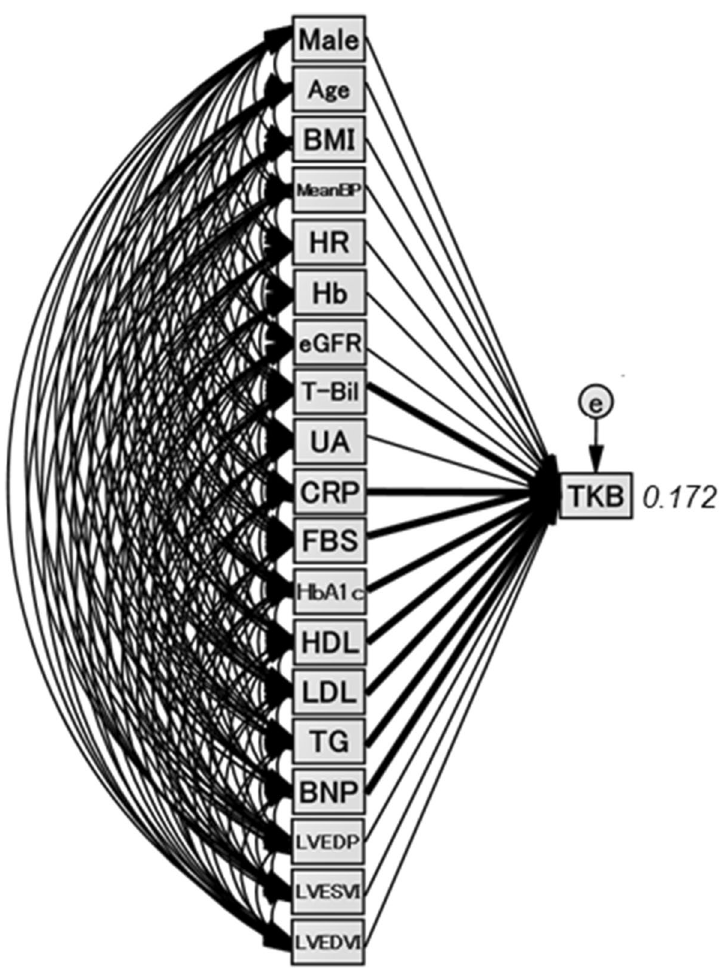
Figure 1. Path model (A). The path model theoretically proposed to clarify the contribution of each of the factors which are show in Table 2 to TKB. Each path has a coefficient representing the standardized coefficient of a regressing independent variable on a dependent variable of the relevant path. These variables represent the standardized regression coefficients (direct effect) (shown in Table 3) and squared multiple correlations (in narrow italics). BMI body mass index, Mean BP mean blood pressure, HR heart rate, Hb hemoglobin, eGFR estimated glomerular filtration rate, T-Bil total-bilirubin, UA uric acid, CRP C-reactive protein, FBS fasting blood sugar, HDL high-density lipoprotein cholesterol, LDL low-density lipoprotein cholesterol, TG triglyceride, BNP B-type natriuretic peptide, LVEDP left ventricular end-diastolic pressure, LVESVI left ventricular end- systolic volume index, LVEDVI left ventricular end-diastolic volume